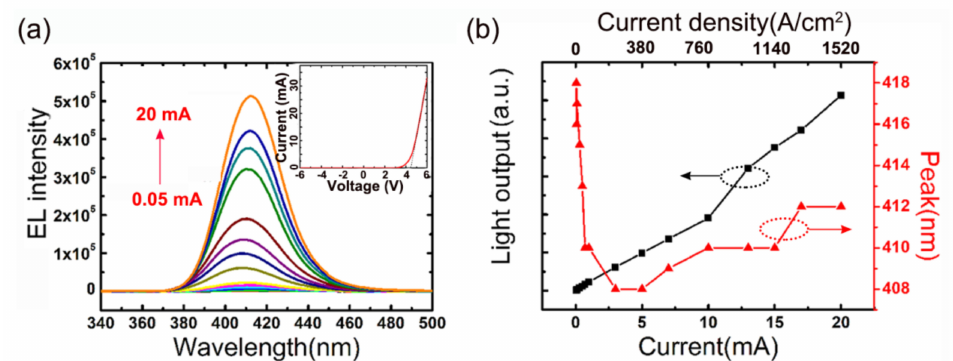
Figure 5. EL spectra of the µ -LED array with injection currents from 0.05 to 20 mA ( a ), where the inserted plot shows the I-V curve of the µ -LED. Light output power and peak position of a single µ -LED pyramid as a function of injection current and current density ( b